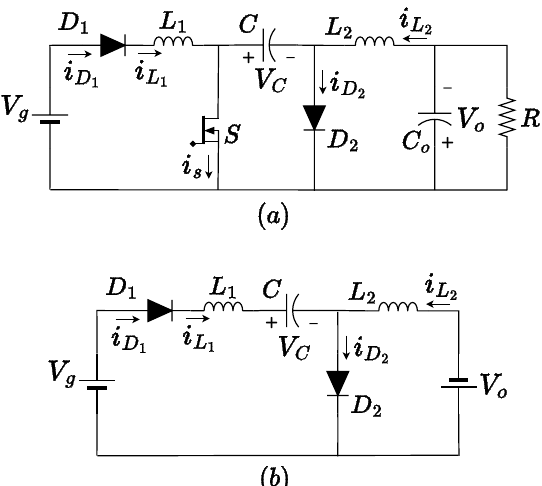
Figure 6. ( a ) ´Cuk modified converter with a diode at the input port, ( b ) equivalent circuit when the transistor is